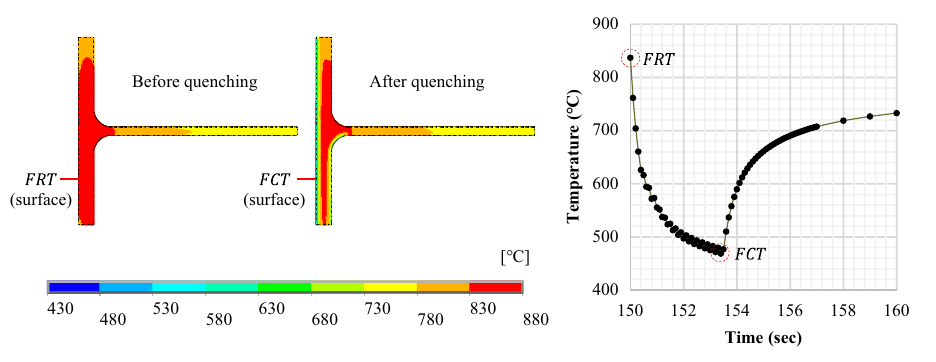
Figure 13. Temperature change during QST with regards to FRT and